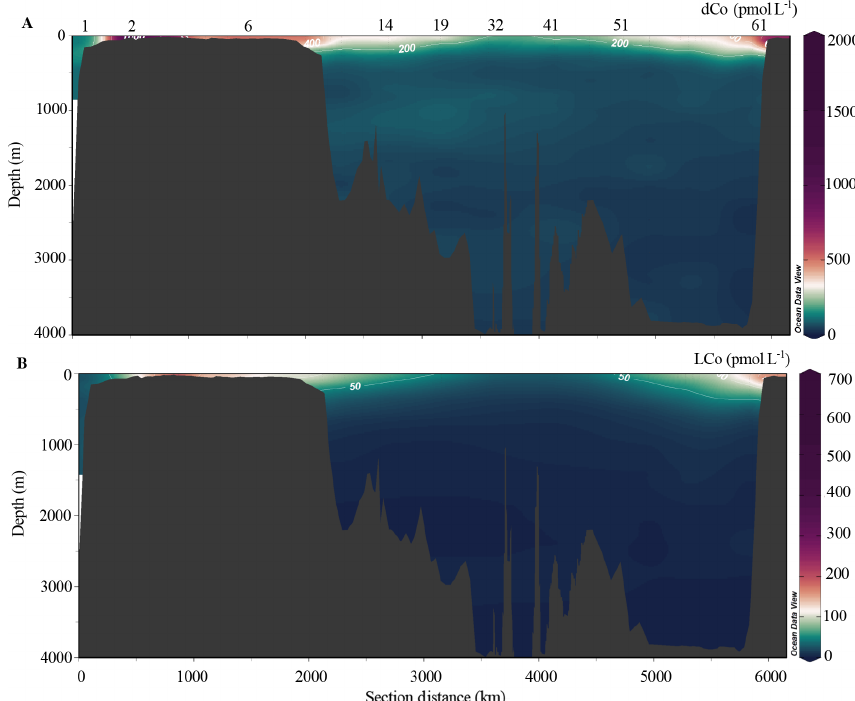
Figure 5. (a) dCo concentrations and (b) LCo concentrations in the Arctic Ocean. Table 2. Median, maximum, and minimum concentrations of total dissolved cobalt (dCo) and labile cobalt (LCo) in samples with repre- sentative water masses and sources in the Arctic Ocean. Median concentrations were determined in each water mass type by using water masses that contained > 95% Atlantic water, > 95% Pacific water, > 10% meteoric water, and > 1 . 5% sea ice melt. Shelf stations were stations 2–10 and 60–66; MIZ stations were 10–17 and 51–57 ( < 30m); and North Pole stations were 27–36 ( < 200m). Ice hole samples were sampled from 1 and 5m. The notation “nd” means not